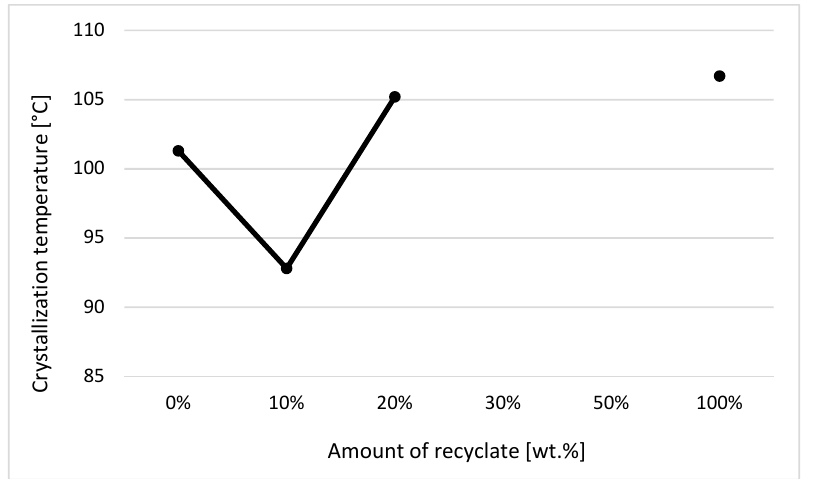
Amount of recyclate [wt.%] Figure 4. Dependence of the change in enthalpy of crystallization on the proportion of weight of the recycled material before exposure of samples to elevated temperature—component 2.